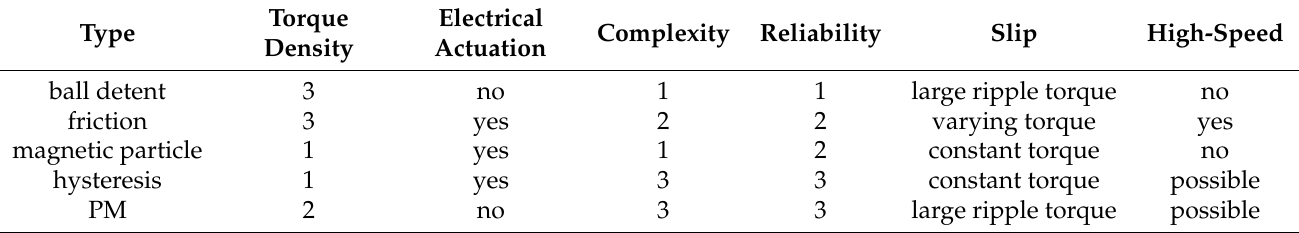
Table 2. Qualitative comparison of torque limiters (higher number denotes better